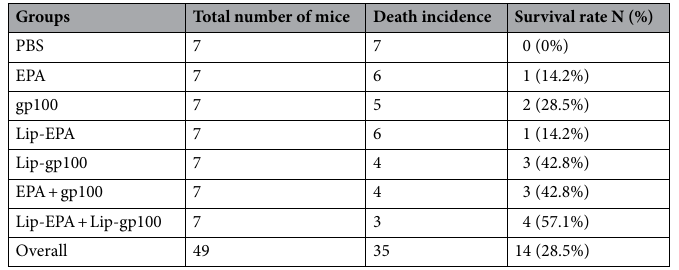
Table 4. Incidence of death and survival rate in different treatment groups.